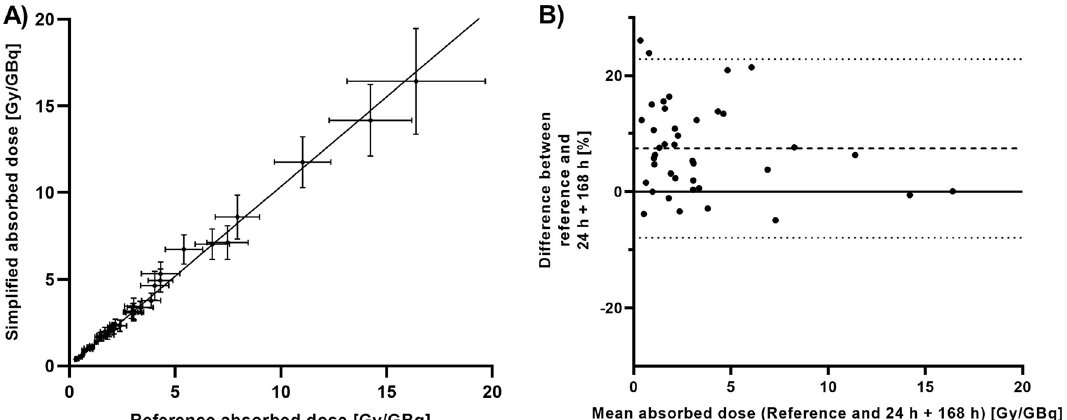
Fig. 2 Results of lesion dosimetry based on two-time point SPECT at 24 and 168 h compared to the reference standard. A concordance between the absorbed dose according to the simplified protocol ( y -axis) and the reference standard ( x -axis). The diagonal line is the line of perfect